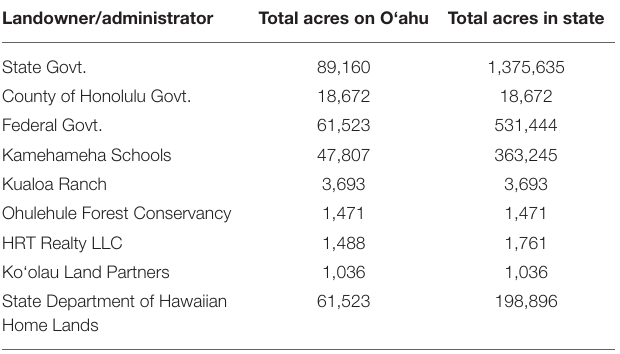
TABLE 4 | Major landowners/administrators in the study area.